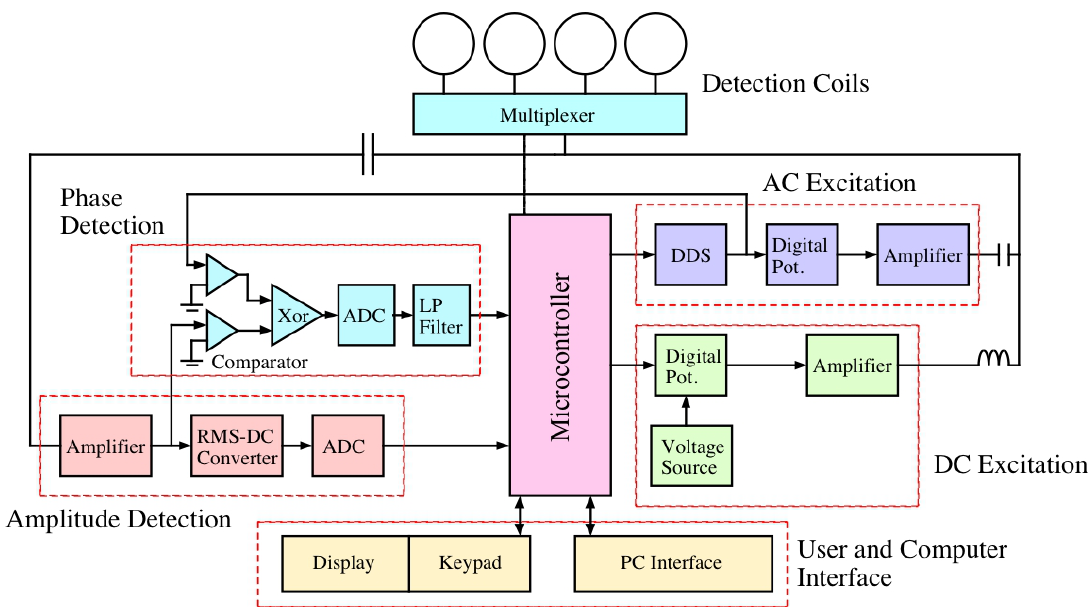
Figure 8. Block diagram of the microcontroller based magnetoelastic sensing system design for simultaneous monitoring of four sensors (four solenoid coils, with a sensor in a each coil). Reprinted with permission from